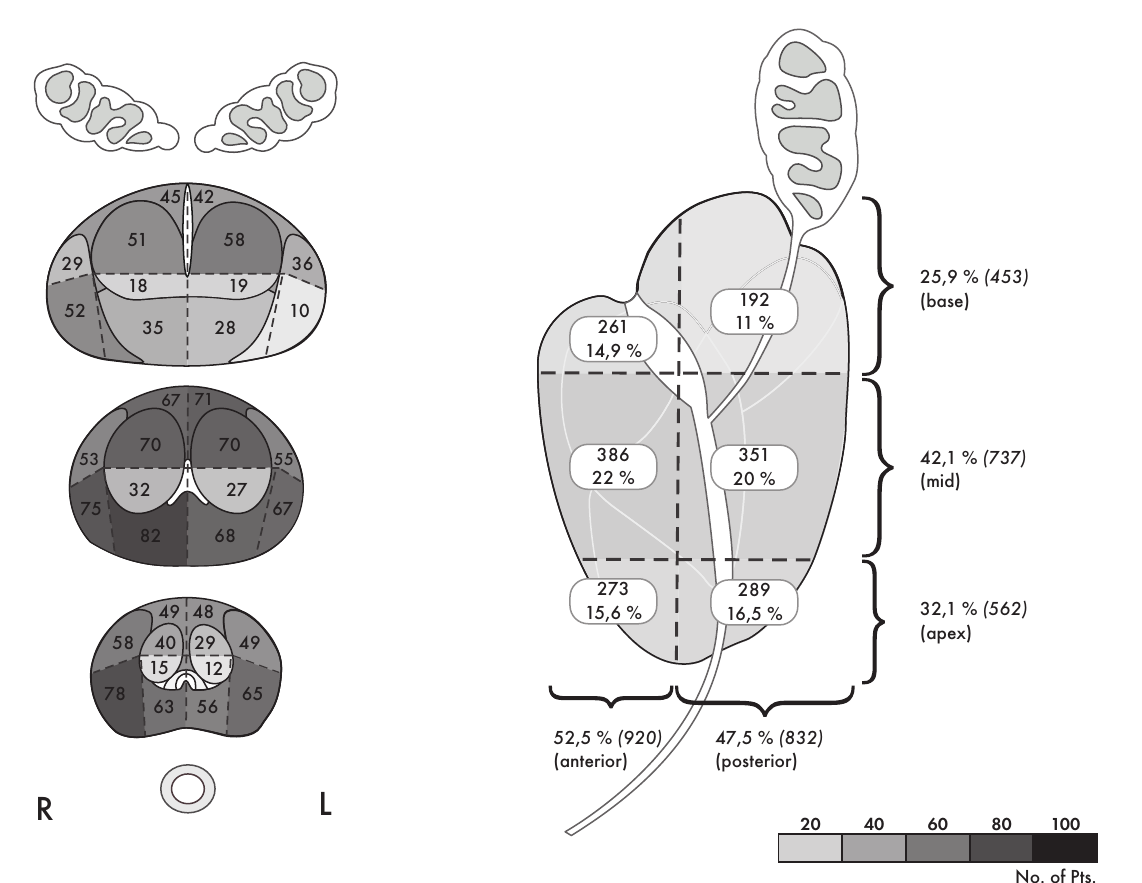
Fig. 2. Number of tumour involvement in the individual segments . According to PIRADS v.2.